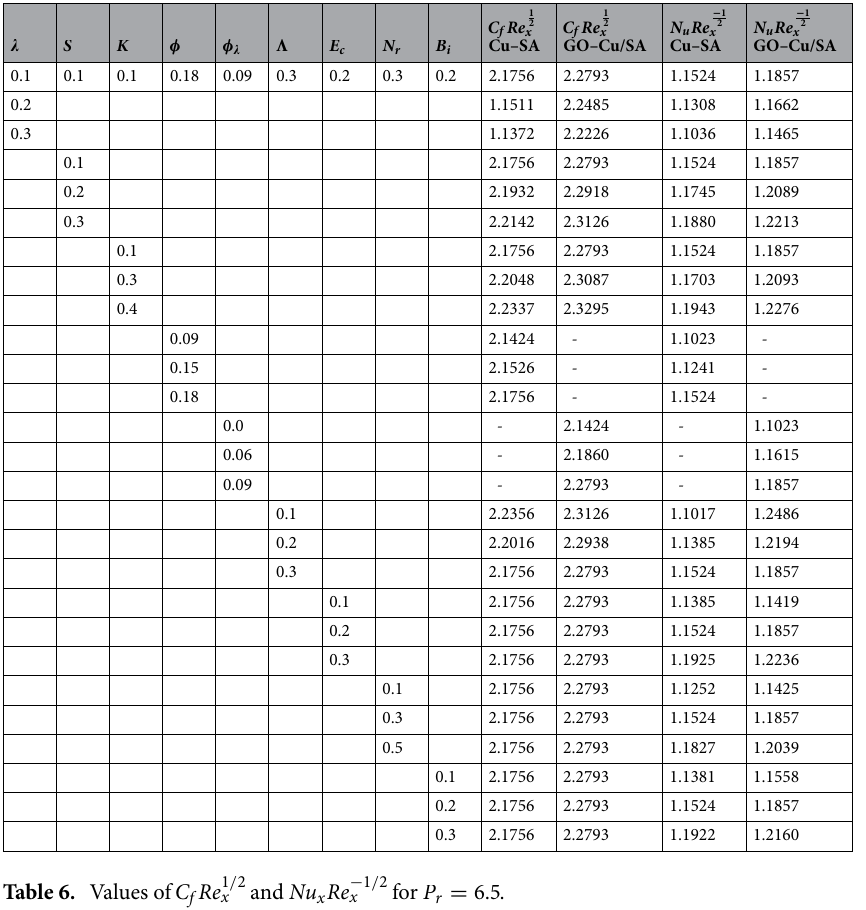
Table 6. Values of C f Re